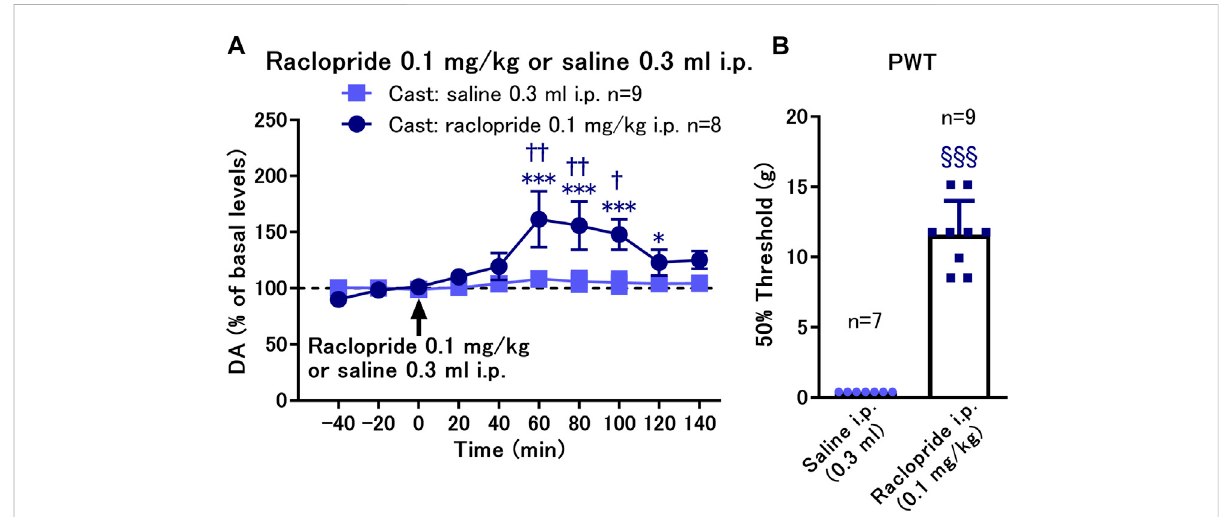
FIGURE 5 Effects of systemic administration of raclopride on the paw withdrawal threshold (PWT) in rats with cast immobilization. (A) Administration of raclopride 0.1 mg/kg, i.p. induced a signi fi cant increase in dopamine (DA) levels. * p < 0.05, *** p < 0.001 versus the basal levels of DA in the same group; mixed linear models; † p < 0.05, †† p < 0.01 between groups with saline and raclopride administration; two-way ANOVA and Sidak ’ s multiple comparisons test; (B) Administration of raclopride reversed the decreased PWT evaluated with von Frey test 60 min after raclopride or